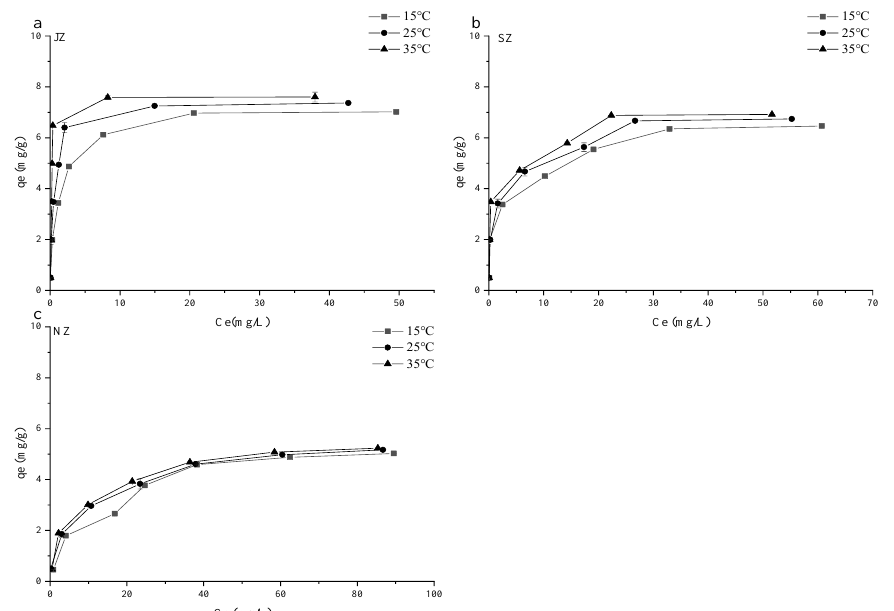
Figure 9. Adsorption curves of Cd for ( a ) JZ, ( b ) SZ, and ( c ) NZ at different temperatures (15, 25, and 35 ◦ C).